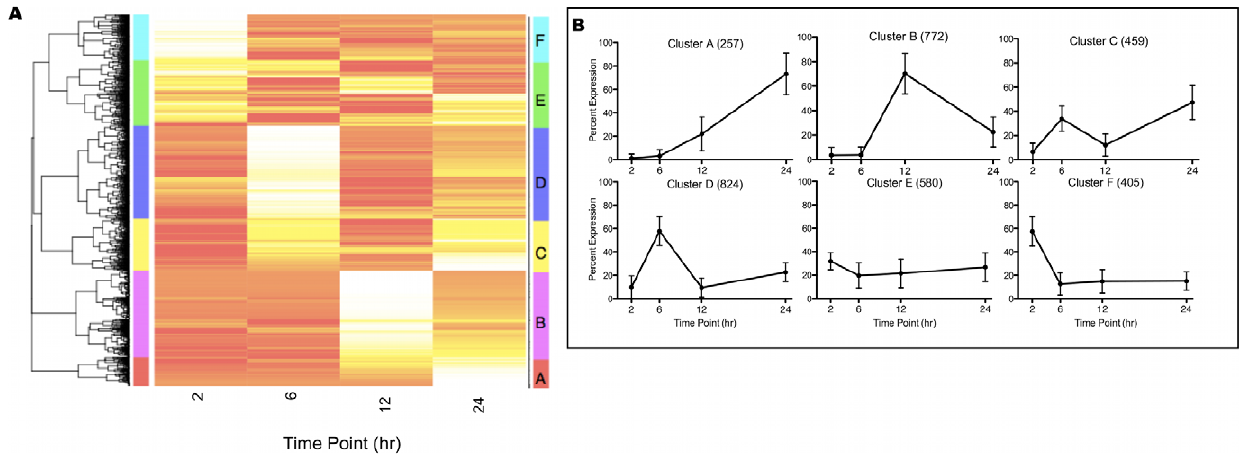
Figure 5. Distribution of Genes Across Clusters. The percentage of each of 13 functional categories was determined across all clusters. Five categories were omitted: Apicomplexan, Cryptosporidium , Oxidative Stress, Hypothetical, and Conserved Hypothetical. Chi-square testing was used to determine any significance in the distribution of the number of genes across clusters using the null hypothesis that the functional classifications would be equally distributed across clusters. Data was using the 2–72 hr (A) and 2–24 hr (B) data sets. Chi-square significance: *= , 0.05, **= , 0.01,